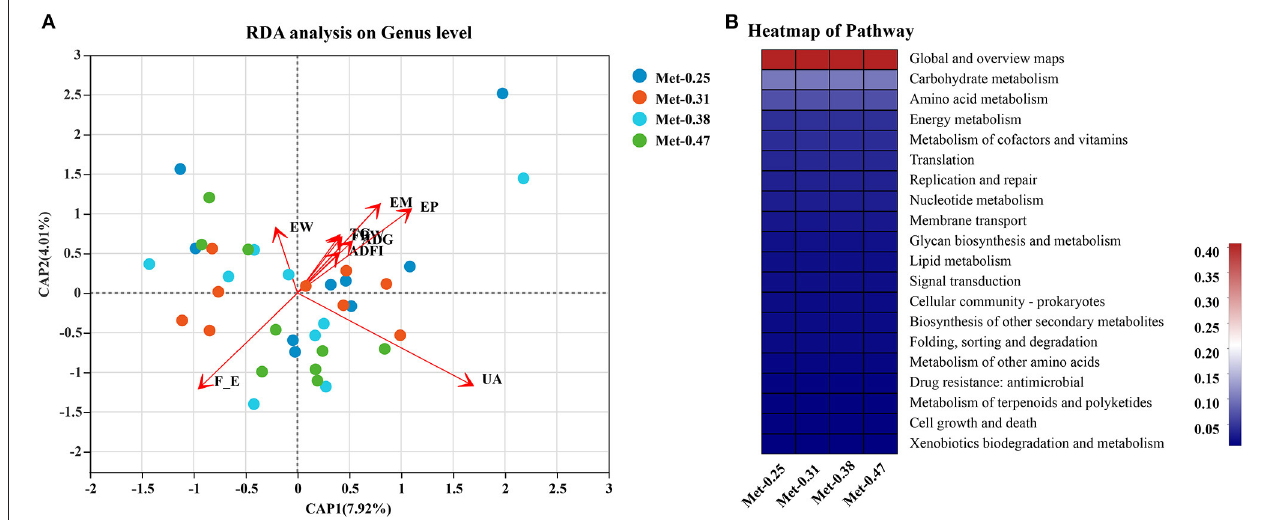
FIGURE 4 | The effects of different dietary Met supplementation in low protein diets on the composition and function of gut microbiota of laying hens. (A) A redundancy analysis (RDA) of the distinctive genera and the phenotype of laying hens. (B) The 20 most significant Kyoto Encyclopedia for Genes and Genomes (KEGG) pathways upon different dietary Met supplementation in low protein diets.